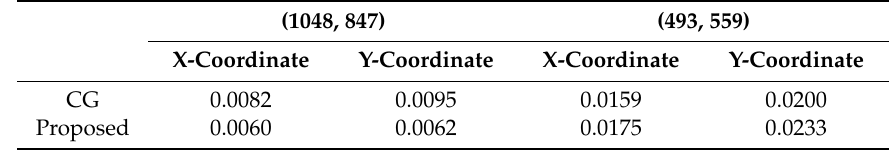
Figure 8c. Due to the distortion of the optical system, the intensity of the star spot does not conform to Gaussian function strictly, making the proposed algorithm perform slightly worse than CG sometimes. Figure 8b is a star spot located near the center of the FOV, the intensity of which conforms to the Gaussian function better. Table 2 shows the standard deviation of the star spots in Figure 8b,c. Table 2. The standard deviation of two star